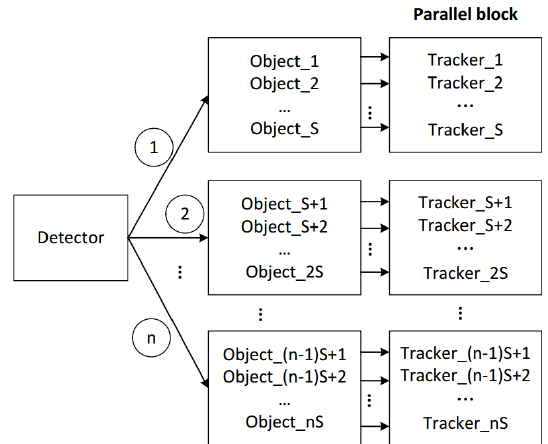
Figure 7. The multi-object tracker. The results of detector are processed sequentially in parallel blocks containing different numbered trackers. S denotes CPU kernel number. The numbers 1 to n are the order of